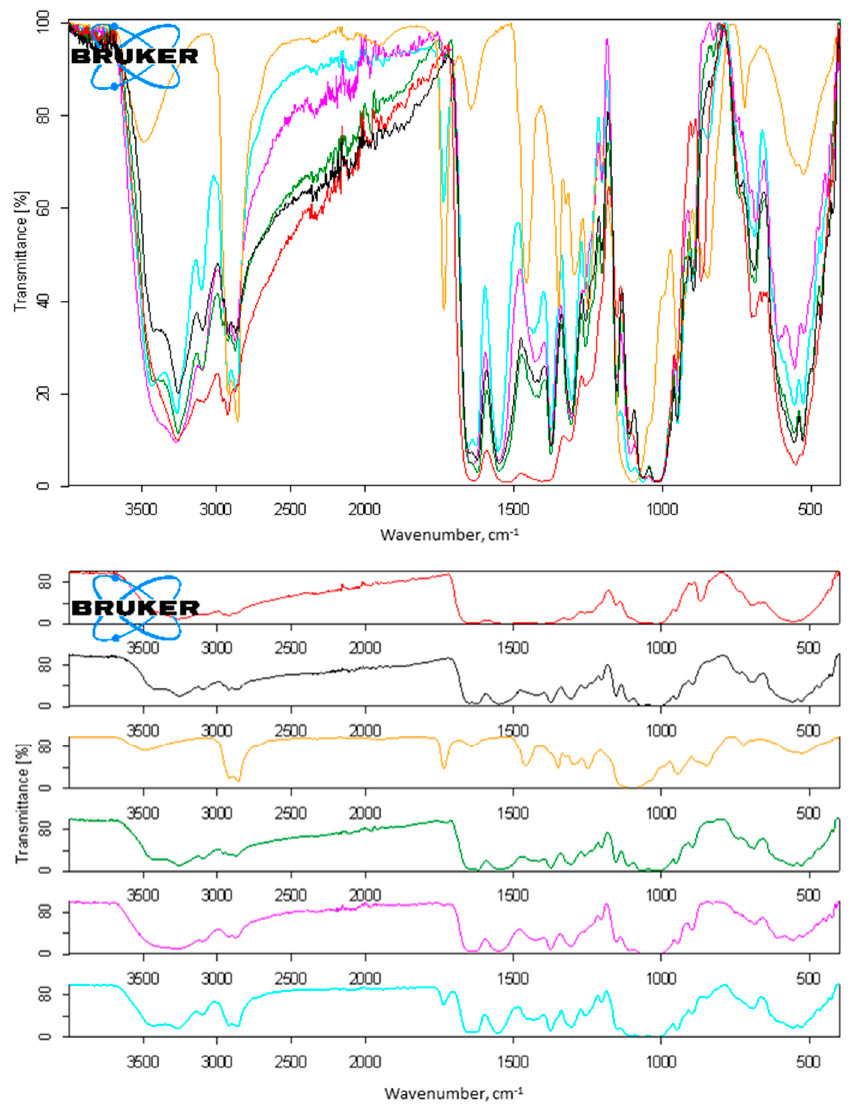
Figure 3. FTIR from chitin utilizing polysorbate 80 for deproteinization (red: shrimp shell biomass; orange: Polysorbate 80; black: IL-chitin; dark green: IL-chitin dry/Polysorbate 80 ; pink: IL-chitin swollen/Polysorbate 80 ; aqua: chitin obtained by coagulation of IL-chitin solution into Polysorbate 80 instead of water. Top : normalized spectra; bottom : stacked spectra.